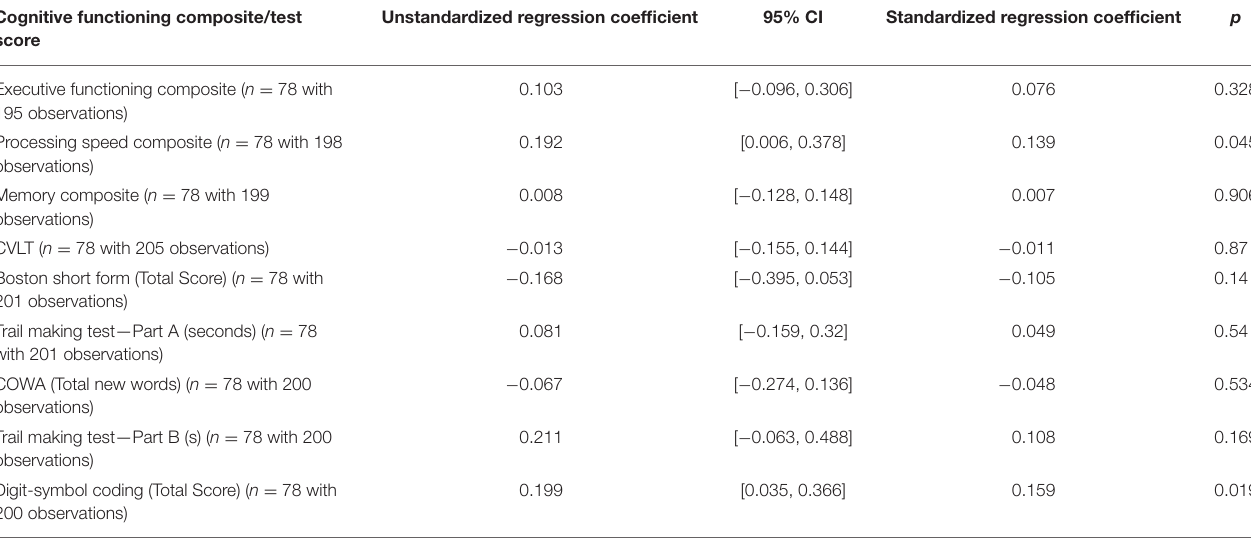
TABLE 3 | The relationship of annualized whole brain atrophy with neuropsychological test performance of Extended-CATCH patients. Cognitive functioning composite/test Unstandardized regression coefficient 95% CI Standardized regression coefficient score